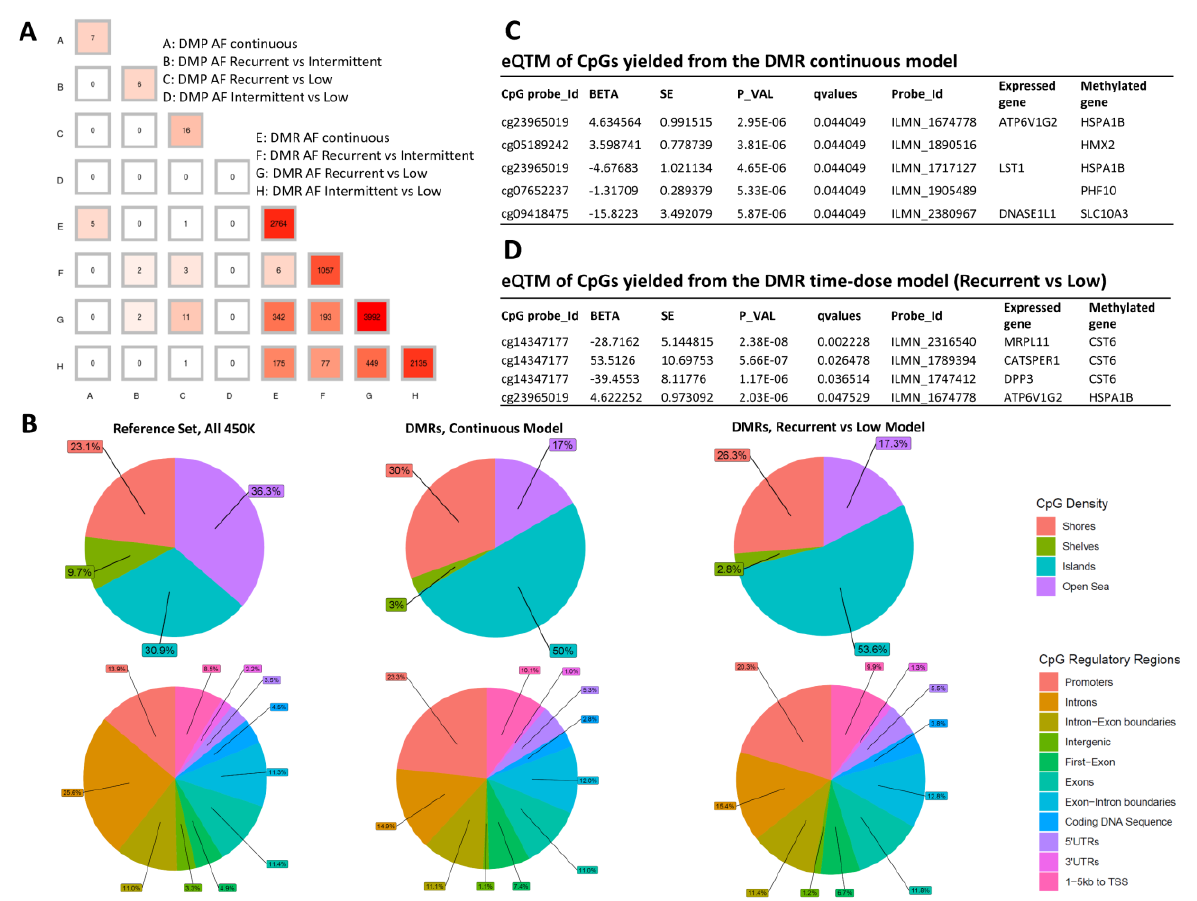
Figure 5. ( A ) The number of CpGs overlapping between the different reported models, A–H. ( B ) CpG Density (upper row) and Regulatory Region (lower row) distributions of the DMRs relative to the whole 450 K probe set (used as a reference). ( C , D ) expression Quantitative Trait Methylation (eQTM) analysis showing significant association (FDR < 0.05) between CpG methylation and RNA expression of nearby genes (within ± 250 Kb). The CpGs yielded from the DMR continuous and Recurrent vs. Low exposure models were used in ( C , D ), respectively. In both models, the eQTMs were adjusted for AF levels in order to eliminate any potential direct effect of AF on expression.